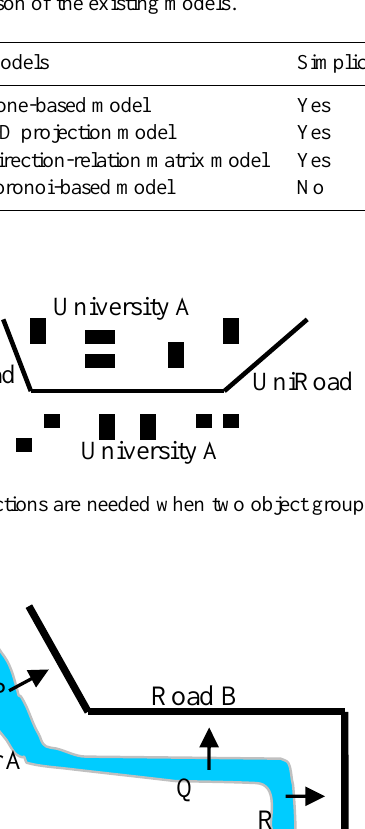
Q R Fig.5 Multi-directions between two Fig. 5. Multi-directions between two approximately parallel object groups. approximately parallel object groups. 6